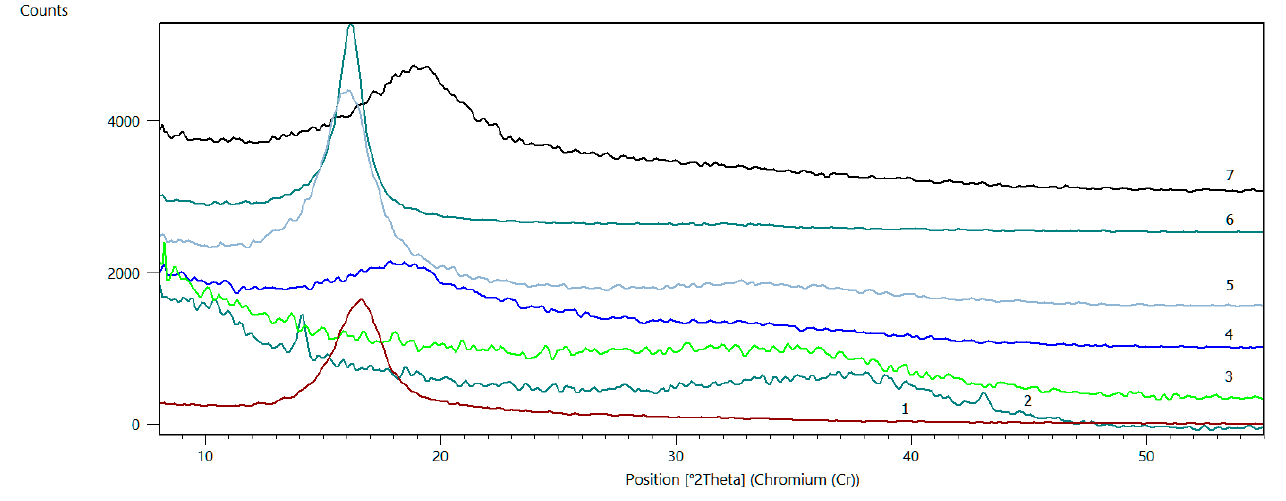
Figure 4. Diffraction patterns of GO and rGO.